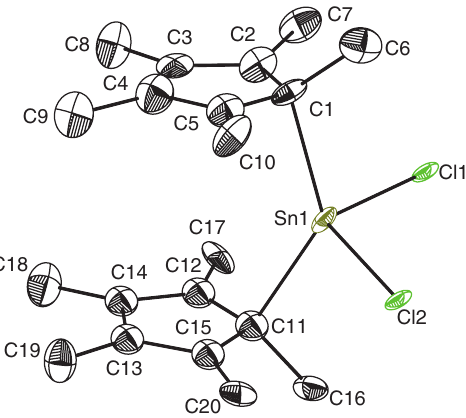
Figure 2: ORTEP at 50% probability and atom numbering scheme for compound C . Hydrogen atoms of the methyl groups are omitted for clarity.